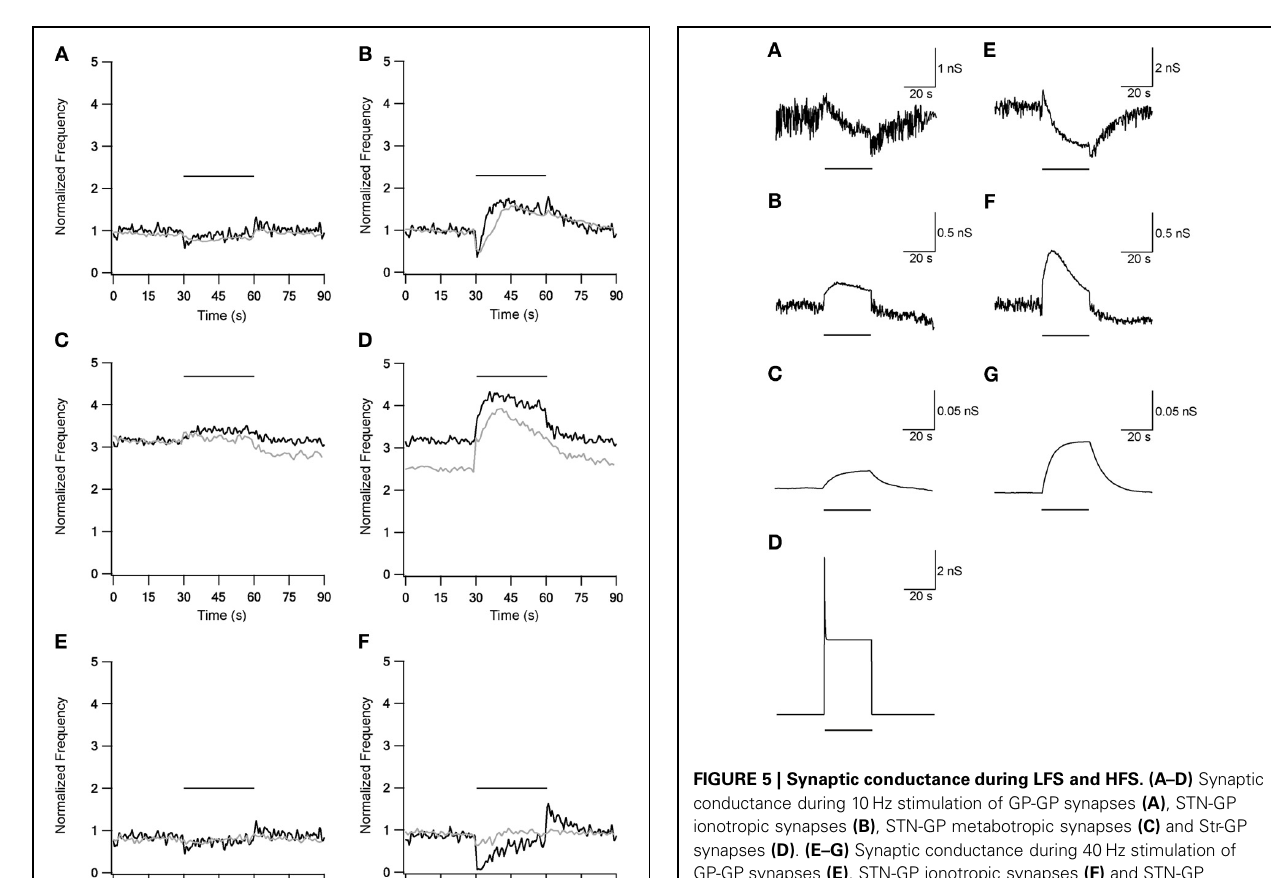
synapses - augmentation time constant ( τ A ), slow depression time constant ( τ D ) and the reaction rate constant Slow